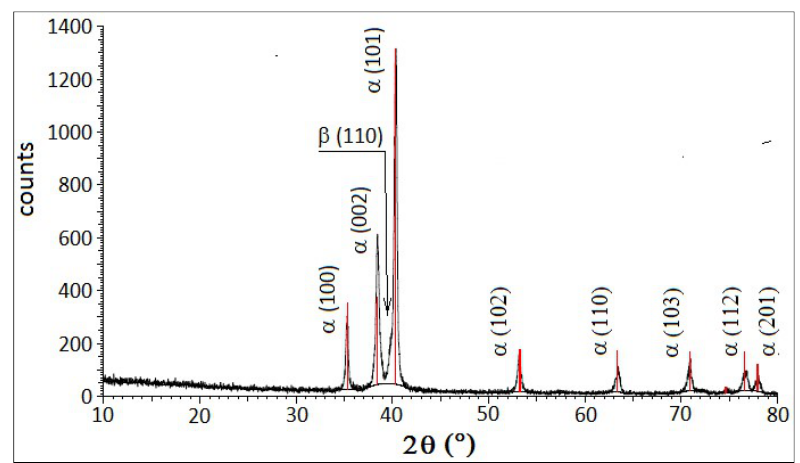
Figure 13. X-ray diffraction (XRD) pattern of an as-built specimen; the red lines indicates the characteristic diffraction peaks of the α phase.